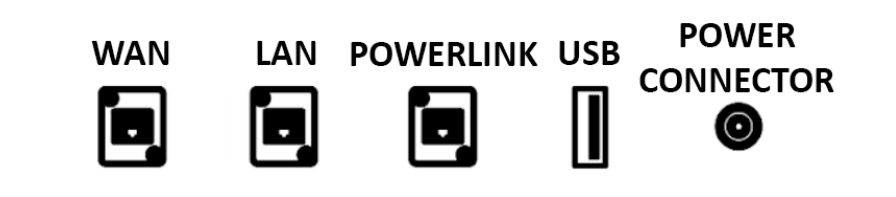
Figure 11. Freely available Phollower interfaces.